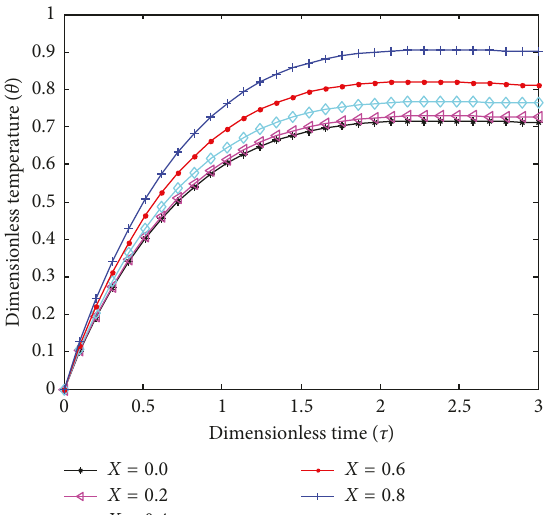
Figure 2: Temperature history in the fin at various locations when the thermal conductivity varies according to linear-law function.